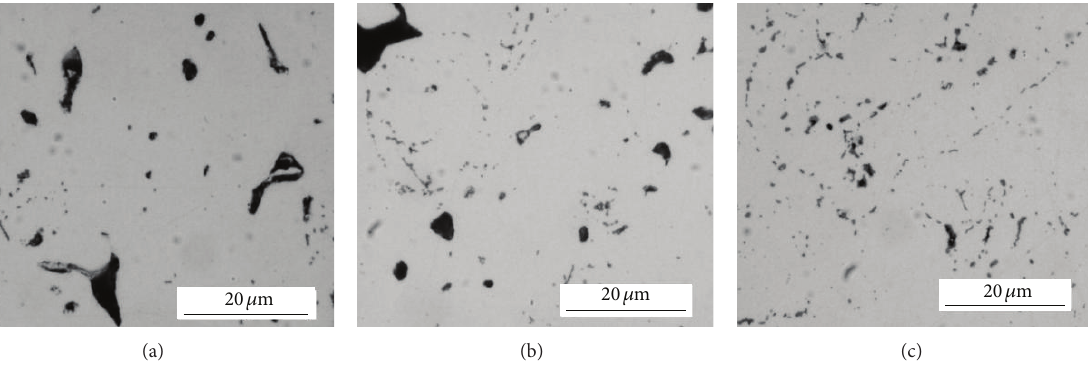
Figure 6: Oxide inclusions in AstCrM + 0.5% C components’ densities of (a) 6.5, (b) 7.1, and (c) 7.4g/cm 3 sintered at 1200 ∘ C for 30 min.